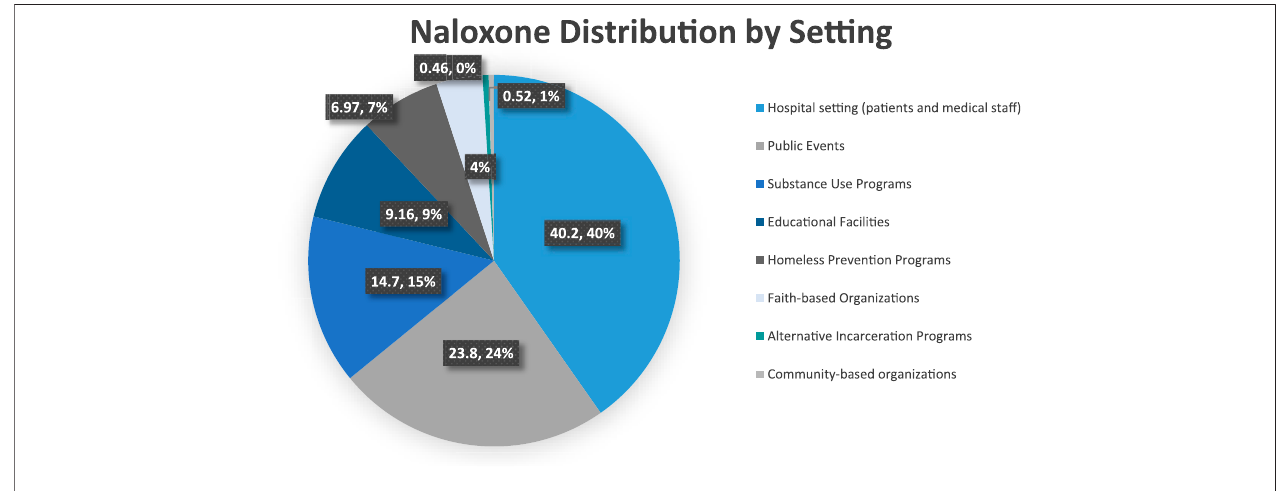
FIGURE 1 | Naloxone distribution by setting.